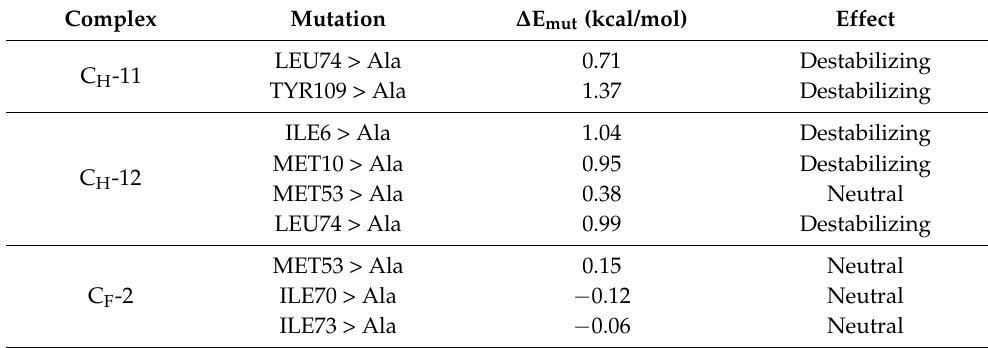
Table 4. Computational alanine scanning (CAS) identified key residues contributing to SnocOBP12– ligand